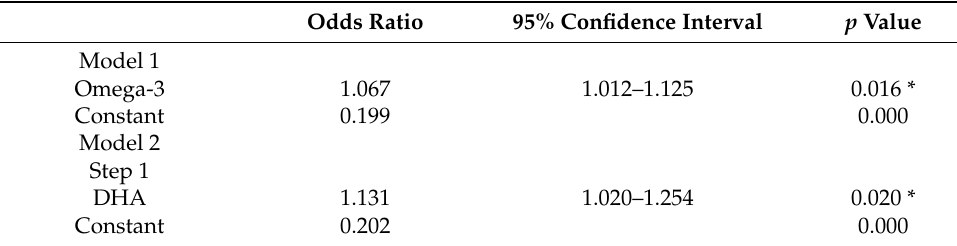
Table 3. Multiple logistic regression of predisposing factors for cognitive decline vs. cognitive stability in patients with AD receiving